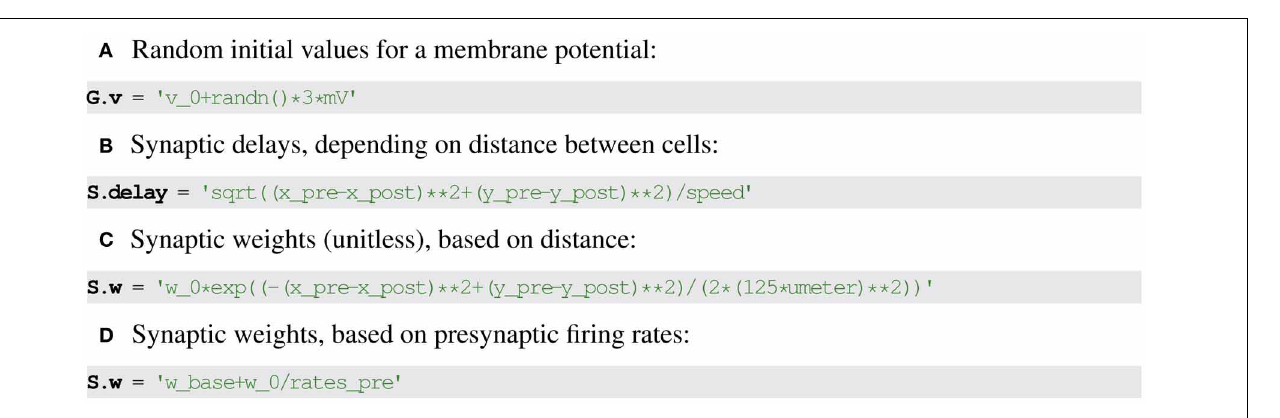
FIGURE 6 | Examples for specifying initial state variable values in Brian2. (A) Neuronal variables. (B–D) Synaptic variables based on pre- and post-synaptic neuronal variables indicated with suffix _pre and _post